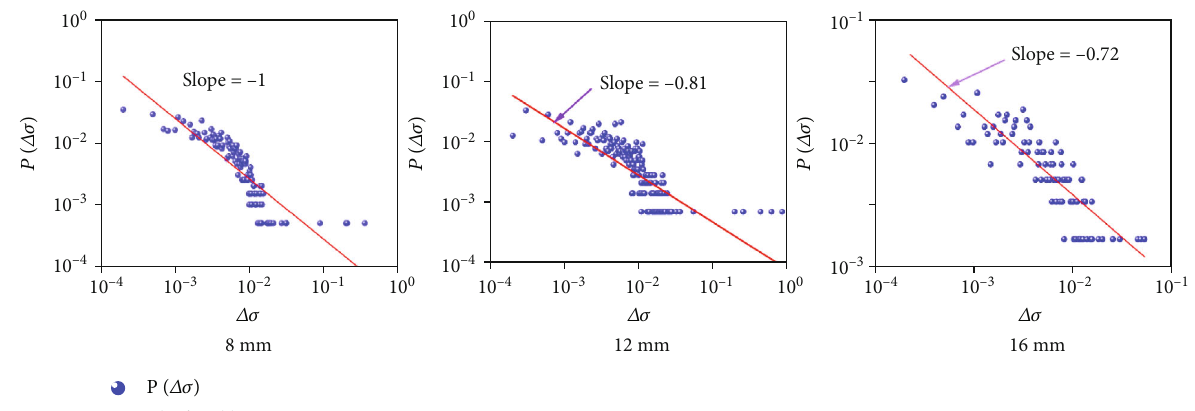
Figure 5: Stress drop probability density map.